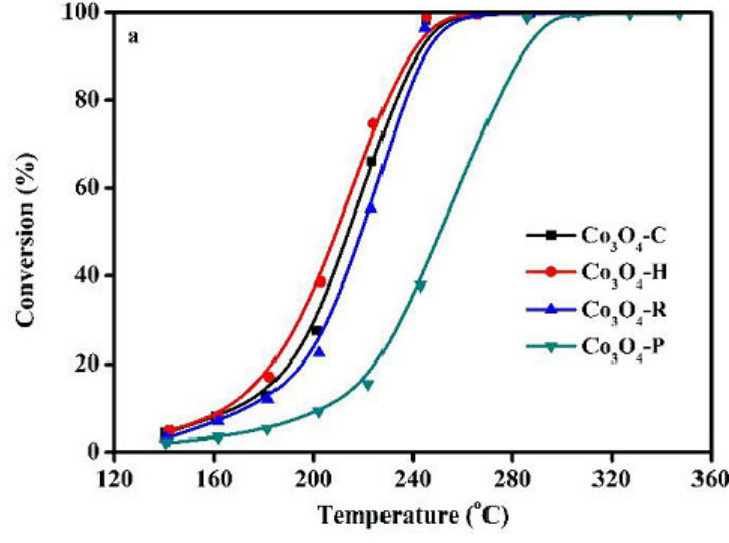
Figure 9. C 3 H 8 combustion activities vs. temperature profiles of investigated catalysts. Reprinted and adapted with permission from Ref. [69]. Copyright 2019 John Wiley and Sons.